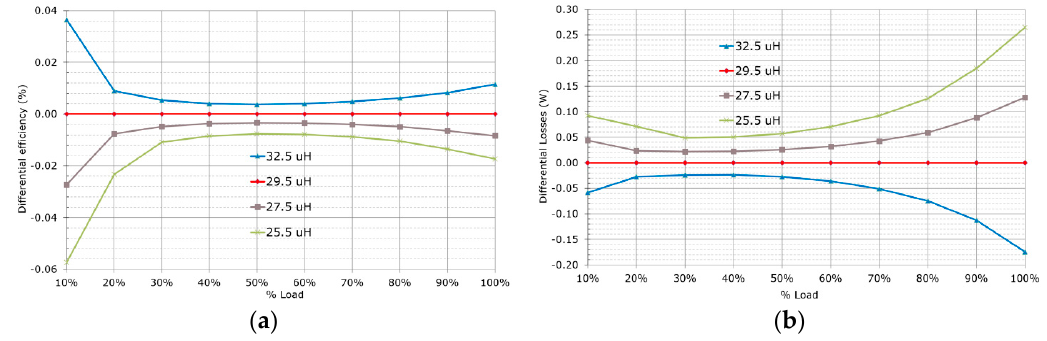
Figure 11. Performance comparison for different external resonant inductances: ( a ) differential efficiency; ( b ) differential losses.